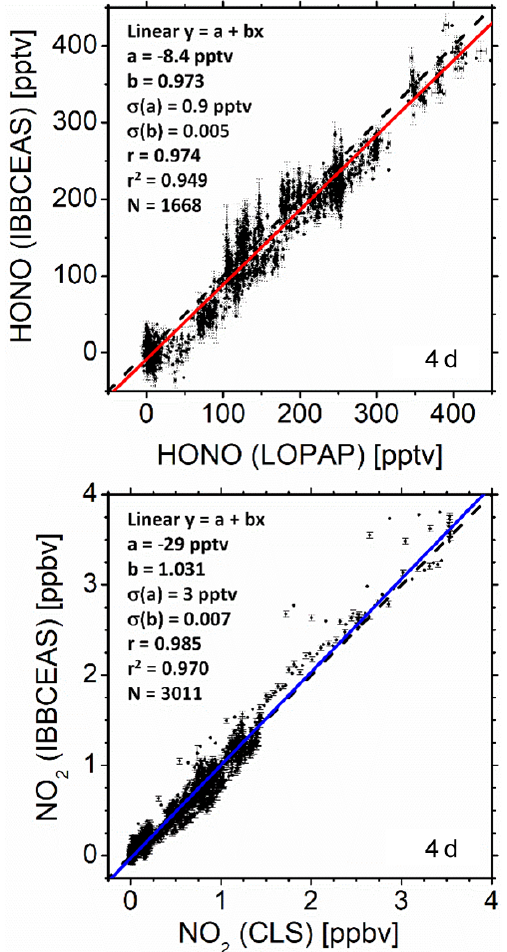
Figure 6. Correlation plots of two instruments of the entire data set from the intercomparison. The dashed line represents the identity, and the coloured solid lines are linear regressions to the data (see also Table